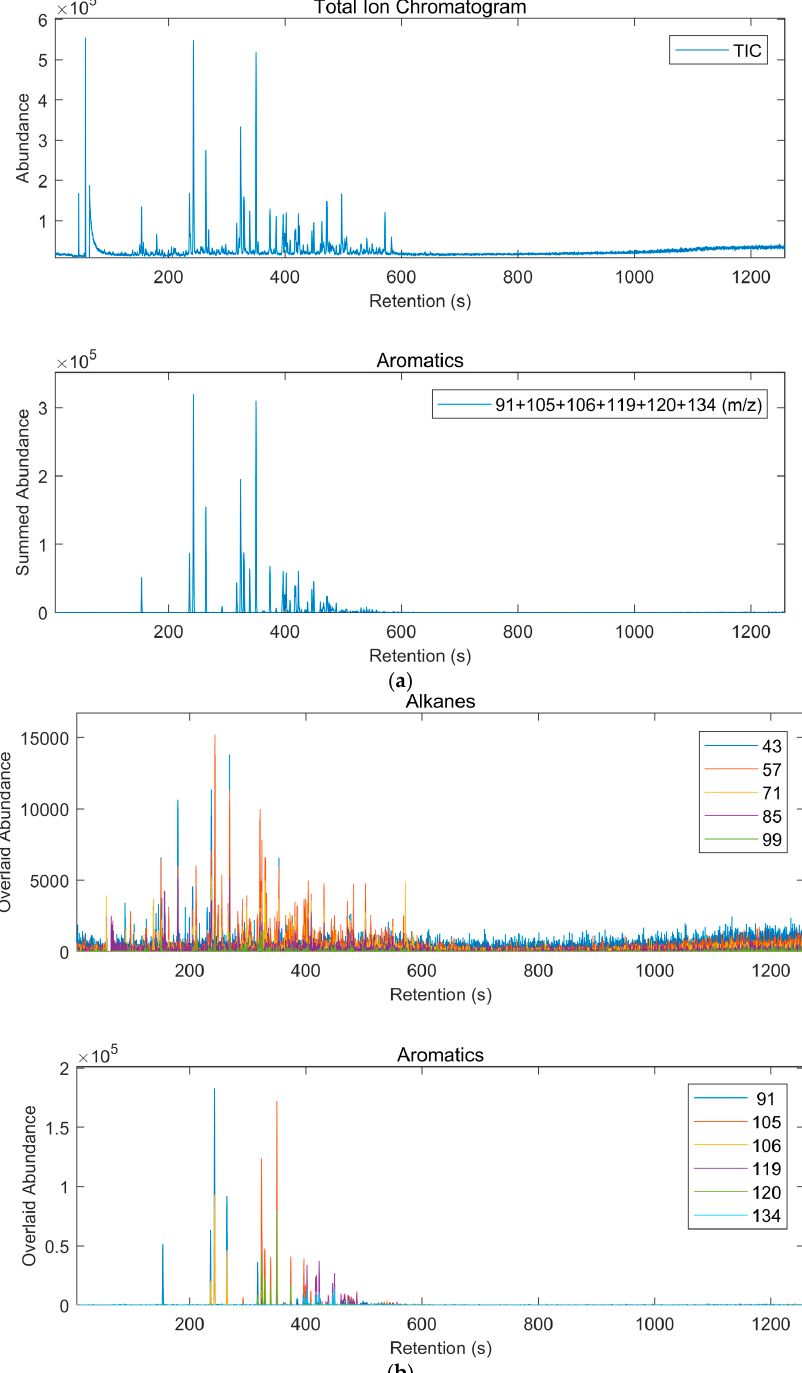
Figure 1. Sample of 1D GC-MSD data for the most abundant gasoline level tested (1.0 μ L/mL) as: ( a ) TIC and summed aromatic EIC; and ( b ) alkane and aromatic EICs displayed as overlays of individual ion chromatograms.